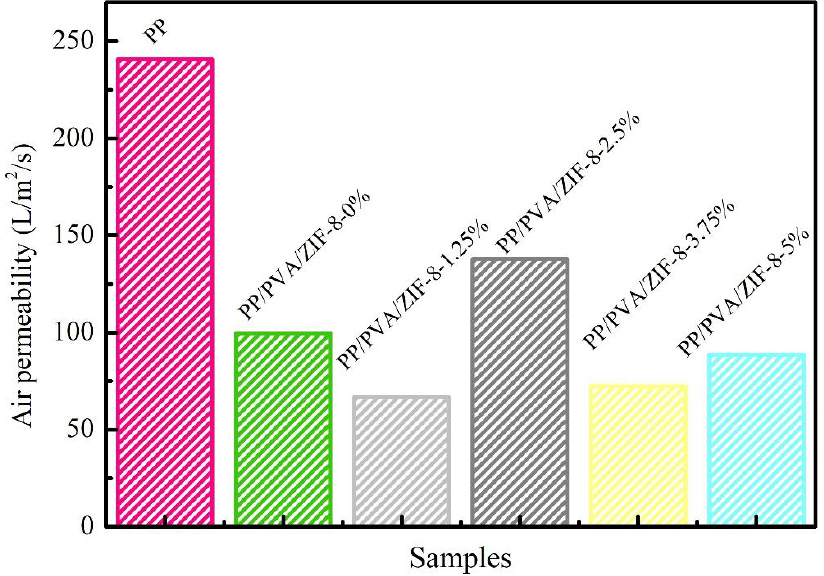
Figure 13. Air permeability of PP melt-blown membranes and PP / PVA / ZIF-8 melt-blown electrospun composite membranes.